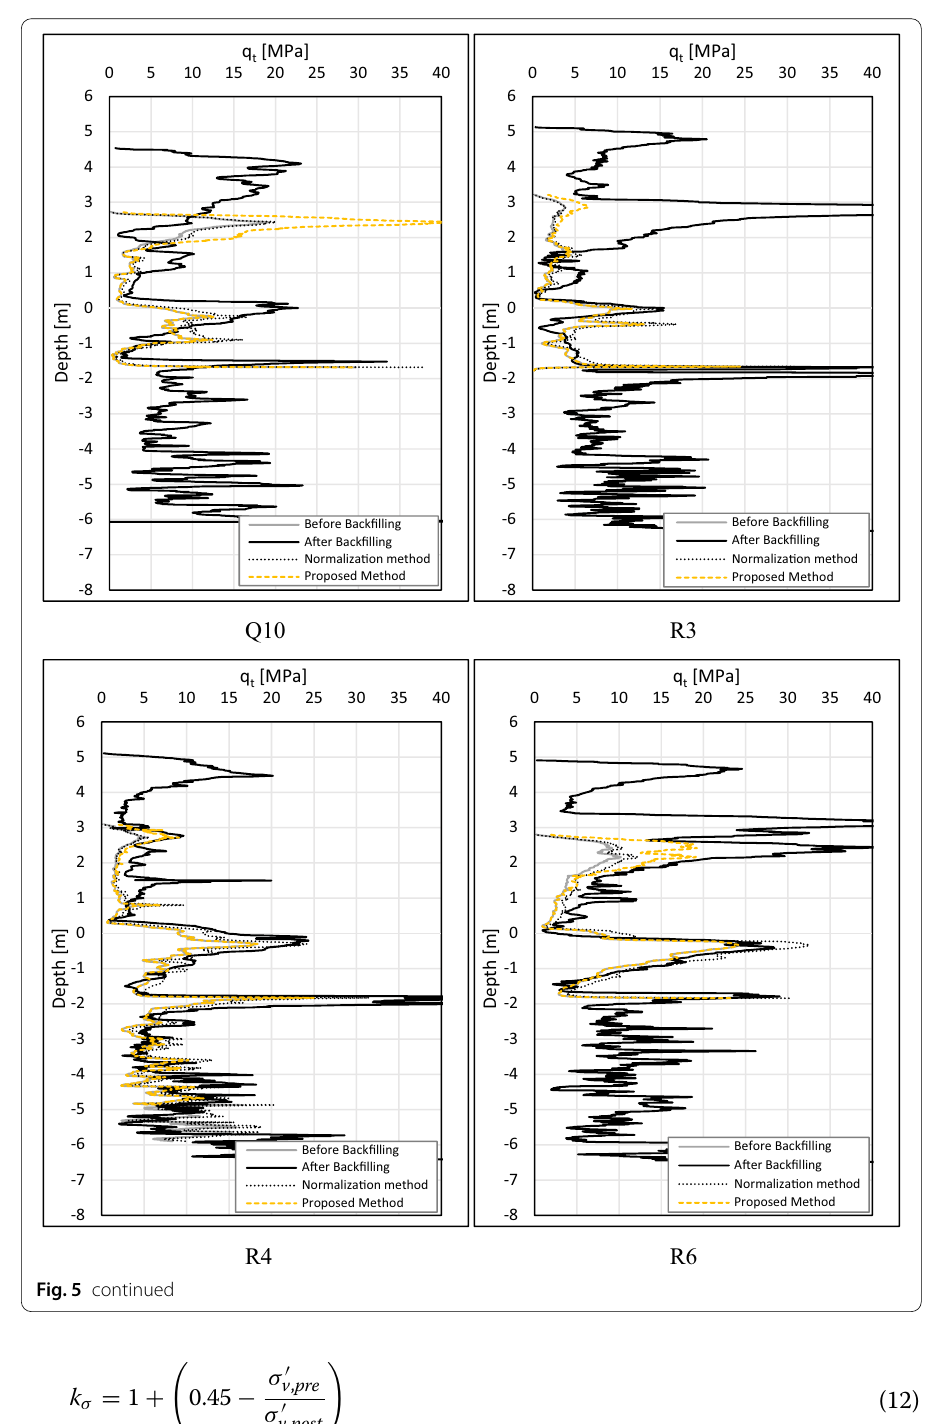
Normaliza(cid:29)on method Proposed